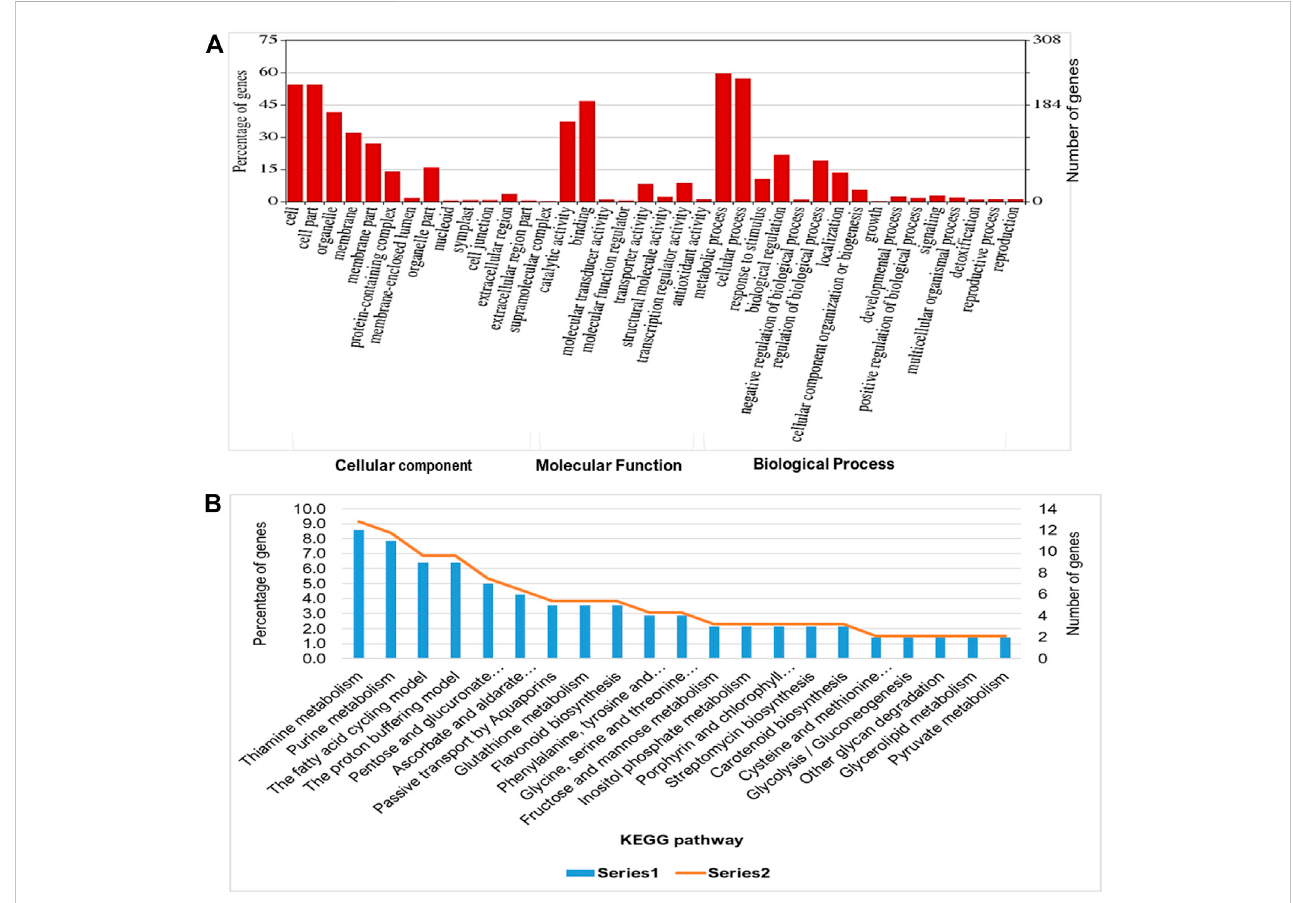
FIGURE 2 Functional enrichment analysis of predicted transcript targets during waterlogging stress in pigeon pea: (A) Gene ontology (Cellular components, molecular function, and biological process) and (B) KEGG pathway analysis to annotate the unigenes for waterlogging RNAseq data using BLASTX program.